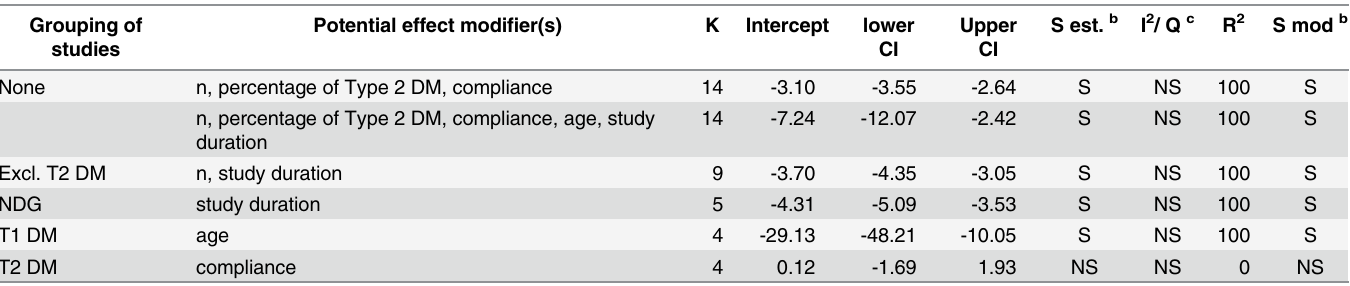
Table 5. Summary of the results of the meta-regression analyses a